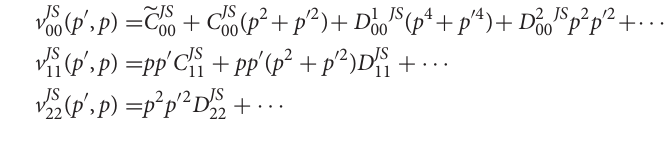
TABLE 8 | Low energy threshold np parameters for all partial waves with j